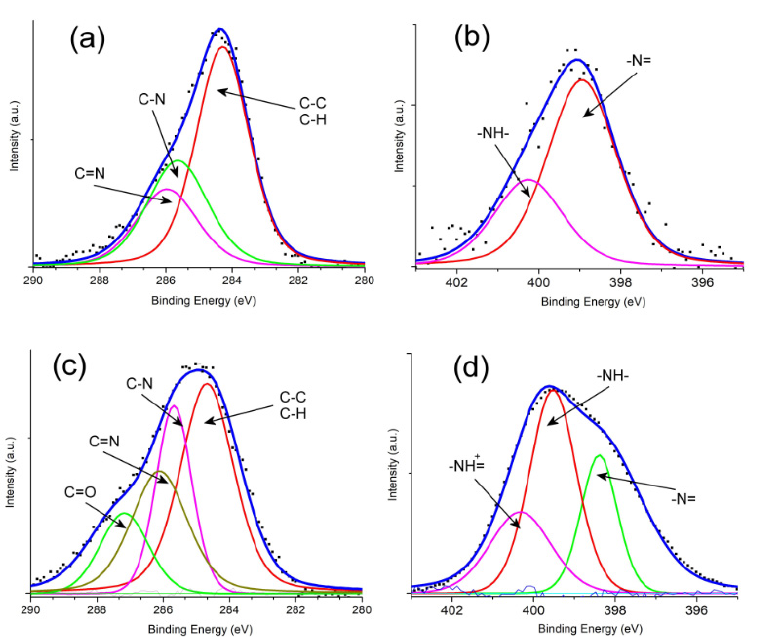
Figure 3. XPS spectral signals: ( a ) C1s of PANI, ( b ) C1s of PANI@TiO 2 –CuO, ( c ) N1s of PANI@TiO 2 – CuO, and ( d ) N1s of PANI.